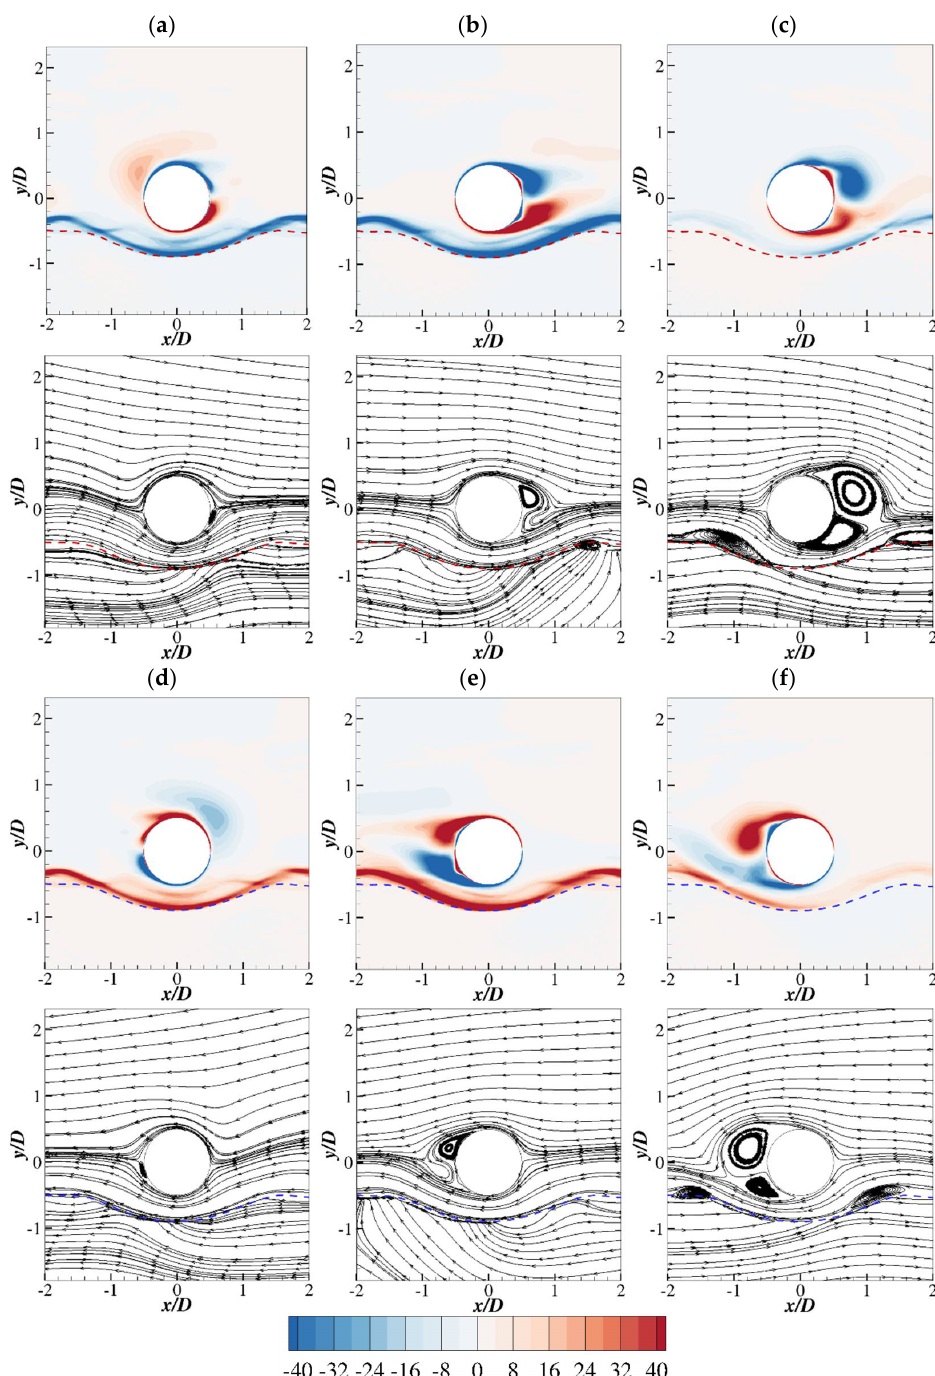
Figure 11. The phase-averaged spanwise vorticity and the streamlines for the single pipeline at the phase of ( a ) T w /6; ( b ) T w /3; ( c ) T w /2; ( d ) 4 T w /3; ( e ) 5 T w /6; ( f ) T w . The dashed lines denote the iso-surface identified by (cid:2038) = 0.5 .